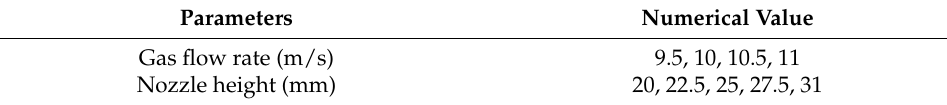
Table 1. Gas jet parameters.